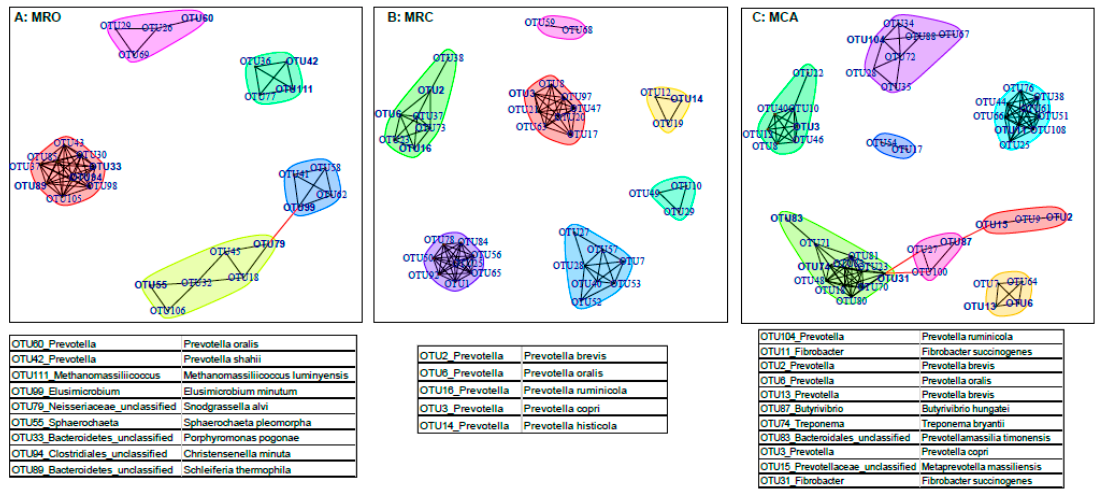
Figure 6. Network analysis of the interactions between bacterial taxa at MRO ( A ), MRC ( B ) and MCA ( C ). The OTUs accounting for >0.5% of the total sequences were selected to network analysis. Each node denotes a particular OTU within the network and each line (edge) represents a significant co-e ffi ciency relationship (Pearson rank correlation coe ffi cient >0.6 or < − 0.6). The table under corresponding figures contained the highlight OTUs and their sequence identifiers with the highest scores from NCBI BALSTN database (other OTUs identifiers were shown in File S2). MRO = milk replacer; MRC = milk replacer + concentrate; MCA = milk replacer + concentrate + alfalfa.